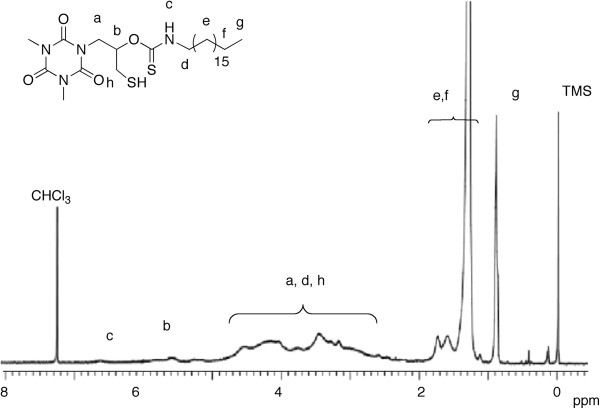
1H-NMR spectrum of OTZnS (400 MHz, CDCl3/CF3COOH (v/v = 5:1)). The assignment of the signals (a-h) is indicated on the structure.